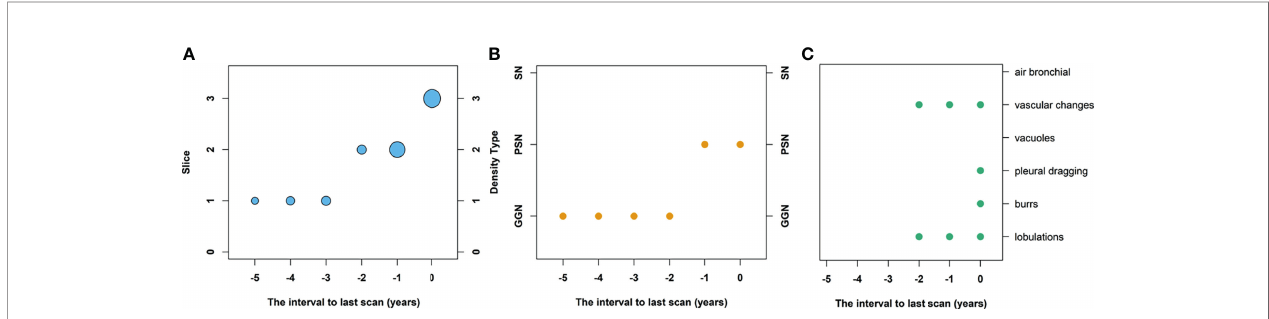
FIGURE 2 | Reverse time map of the size, density, and morphological signs. (A) The reverse time-size bubble plot; (B) reverse time-density type scatter plot; (C) reverse time-morphological signs scatter plot from baseline scan to last